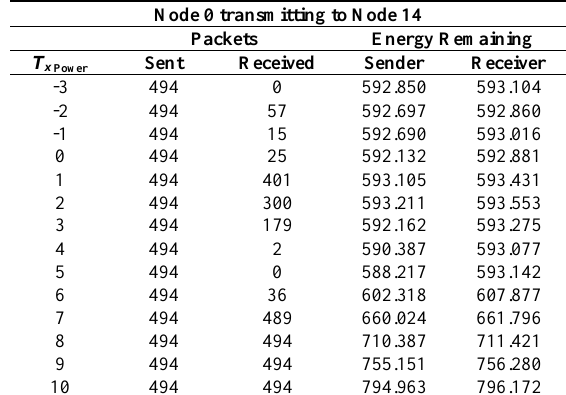
Table 12. Summary of the results under Scenario 2a (Node 0 to Node 14).